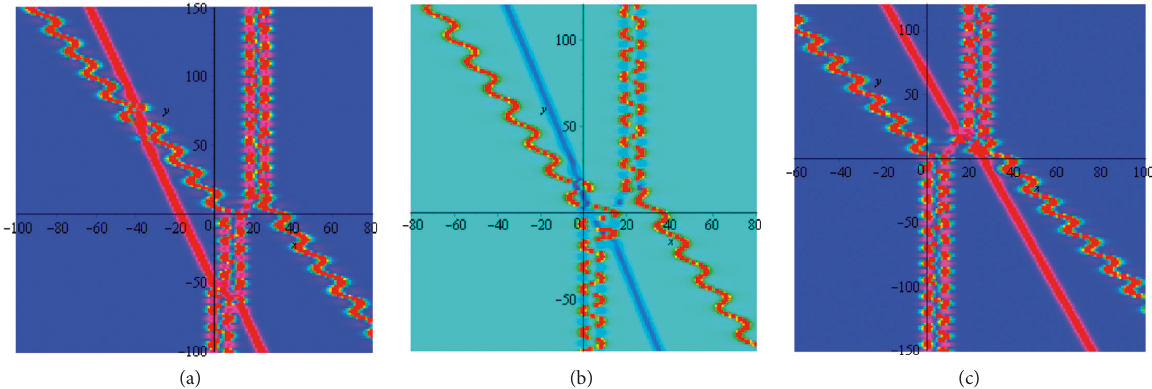
Figure 23: Plots of equation (86) by taking ϕ (c) f 3.